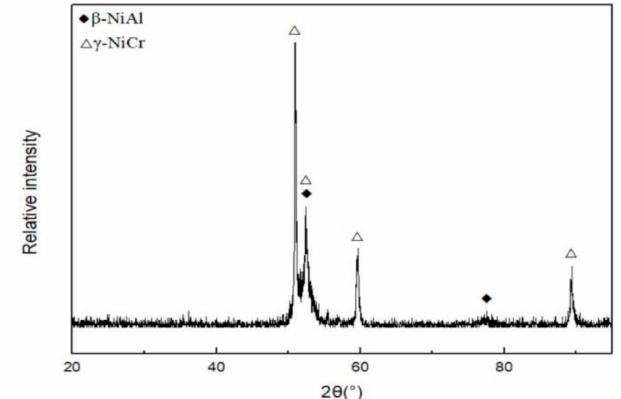
Figure 2. XRD di ff ractogram of feedstock NiCrAlY powder.